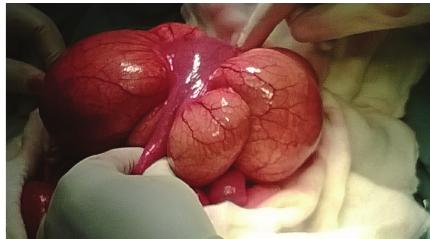
Figure 1: Intestine compressed but viable.